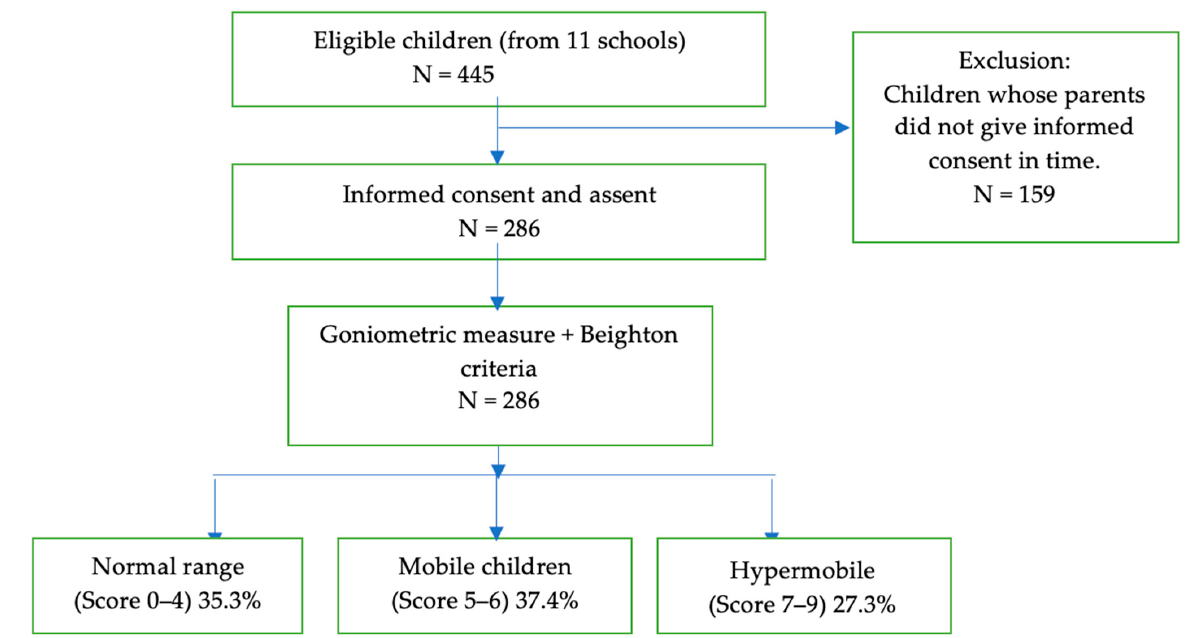
Figure 1. Participant recruitment flowchart depicting the steps in the selection procedure of the children and results per the classification of joint mobility.